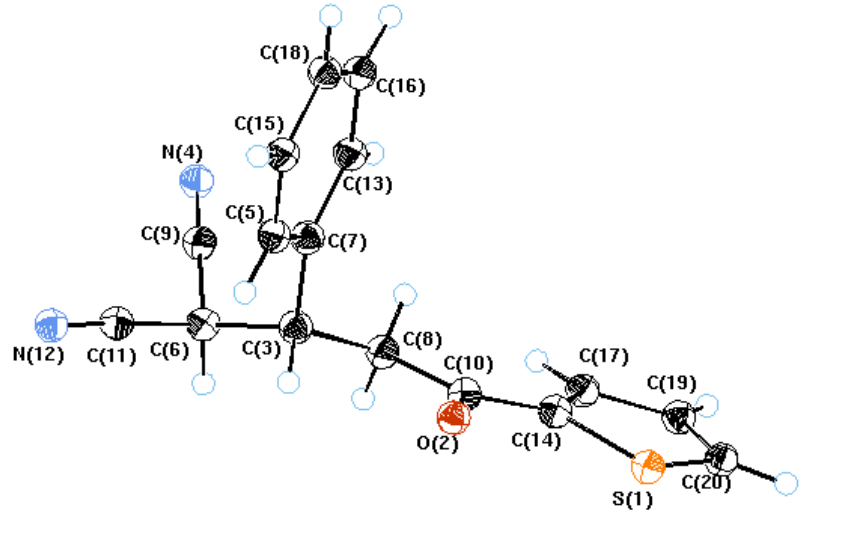
Figure 1. ORTEP projection of single crystal X-ray diffraction of 2 .